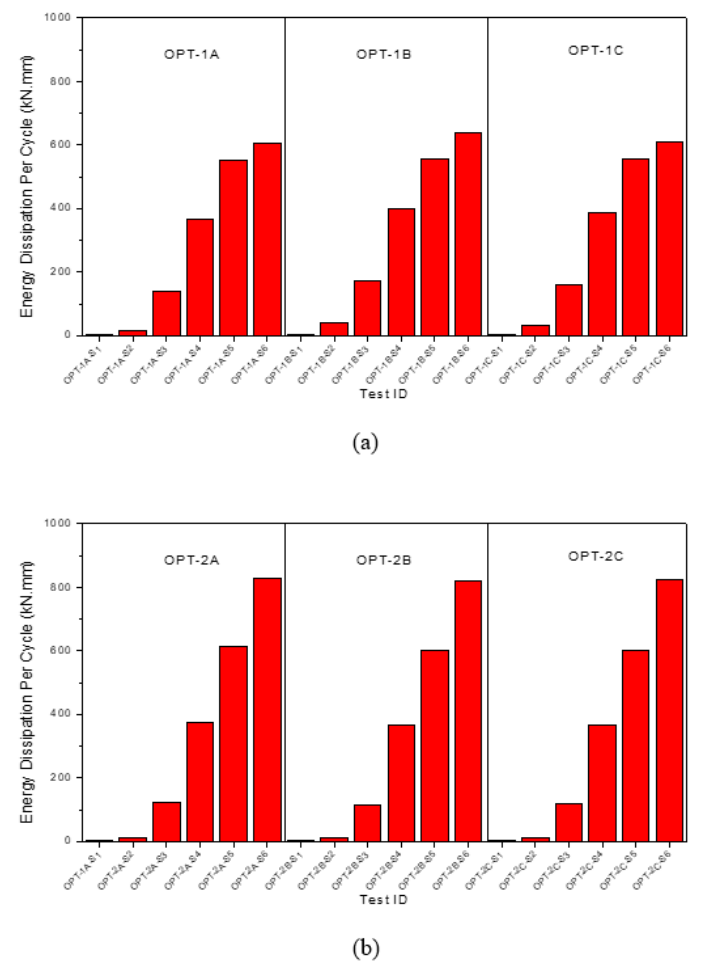
Figure 16. Test results for energy dissipated per cycle (EDC): ( a ) OPT-1; ( b ) OPT-2.